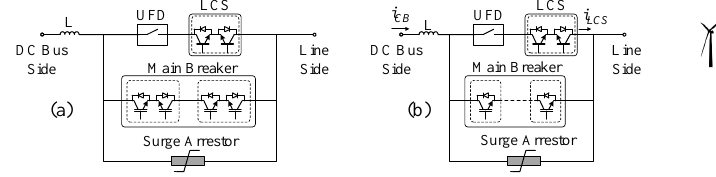
Fig. 3. Hybrid DC circuit breaker (a) typical HCB, (b) UHCB